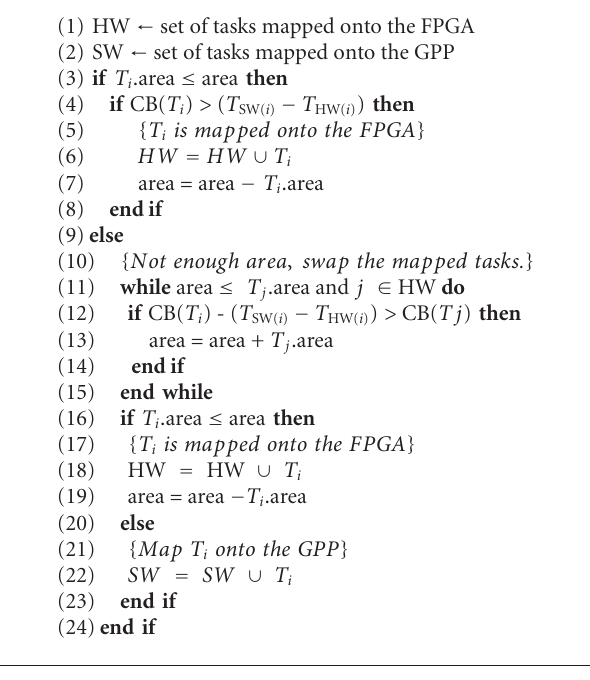
Algorithm 2: Pseudocode for the cumulative benefit heuristic (CBH) for the mapping on task T i .